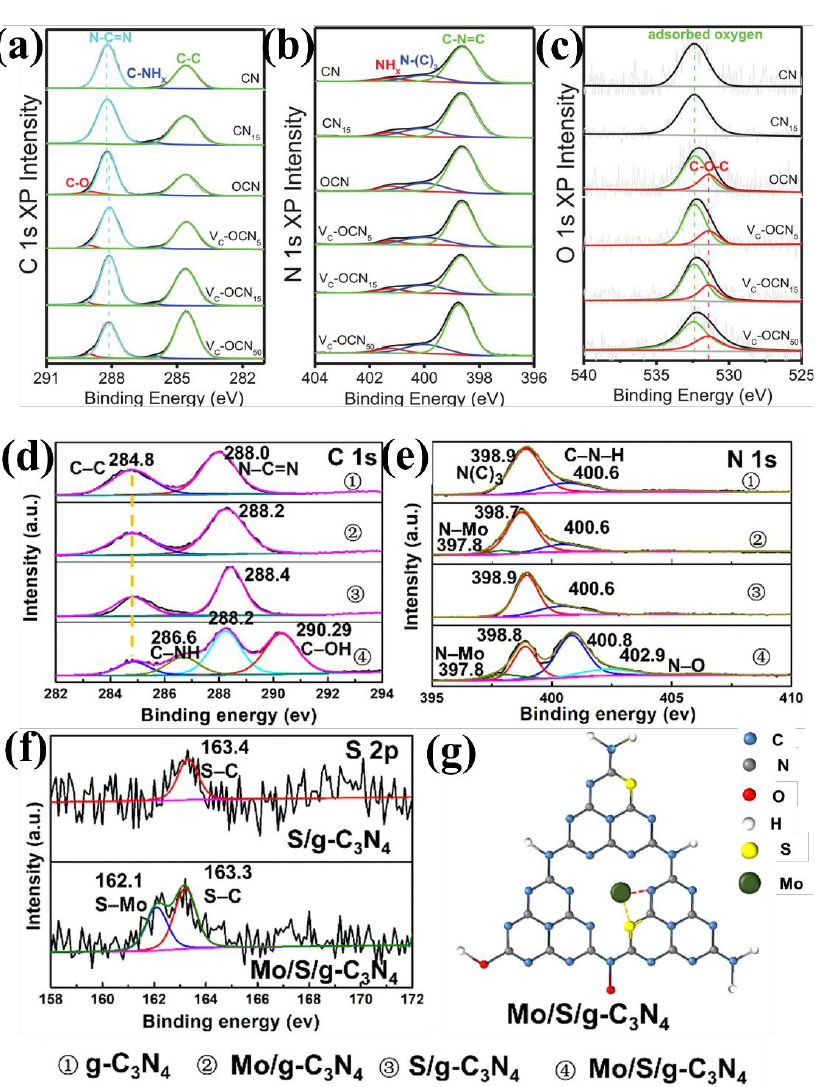
Figure 9. The high-resolution XPS spectra of C 1s ( a ), N 1s ( b ) and O 1s ( c ) of the samples [76]. The high-resolution XPS spectra of C 1s ( d ), N 1s ( e ) and S 2p ( f ) of the samples, and ( g ) the proposed theoretical atomic structure of Mo/S/g-C 3 N 4 [92].